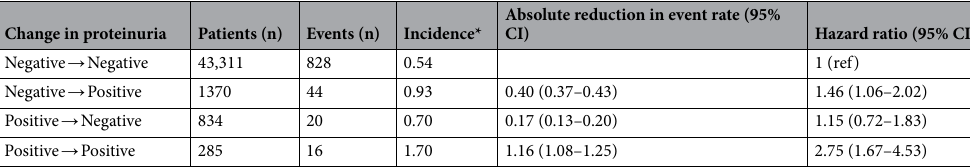
Table 3. Incidence of Atrial Fibrillation according to the follow-up dipstick test. *per 100 Patient-Years. Covariates adjusted for age, sex, BMI, smoking, alcohol, hypertension, dyslipidemia, chronic kidney disease, myocardial infarction, chronic obstructive pulmonary disease, osteoporosis, liver disease, and